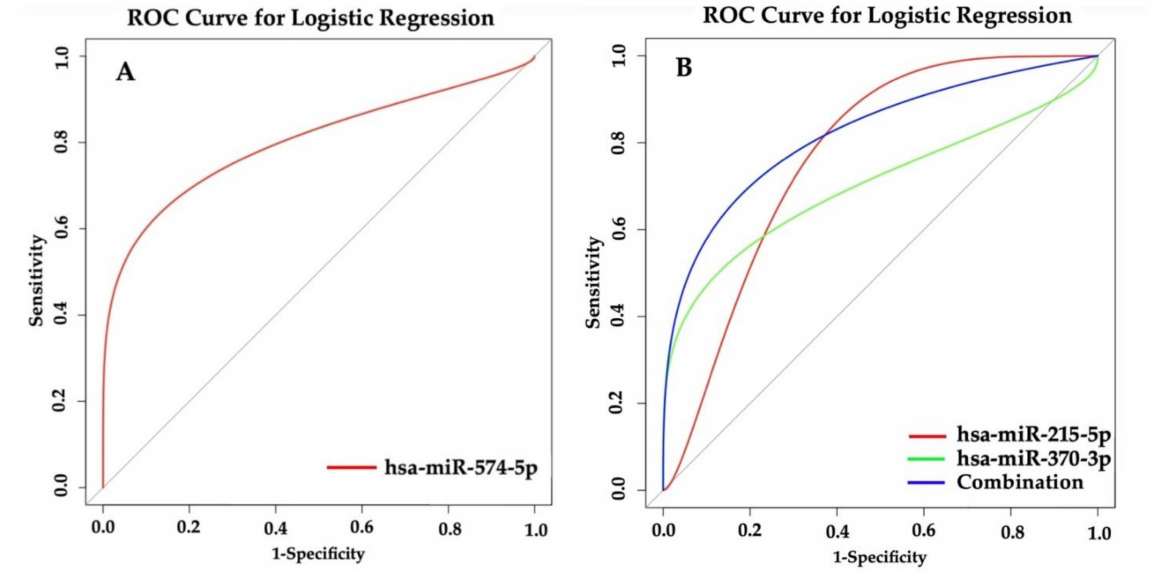
Figure 3. Prediction of hsa-miR-574-5p and the combination of hsa-miR-215-5p and hsa-miR-370-3p in logistic regression model. ( A ) Prediction of hsa-miR-574-5p in logistic regression model. ( B ) Prediction of the combination of has-miR-215-5p and hsa-miR-370-3p in the logistic regression